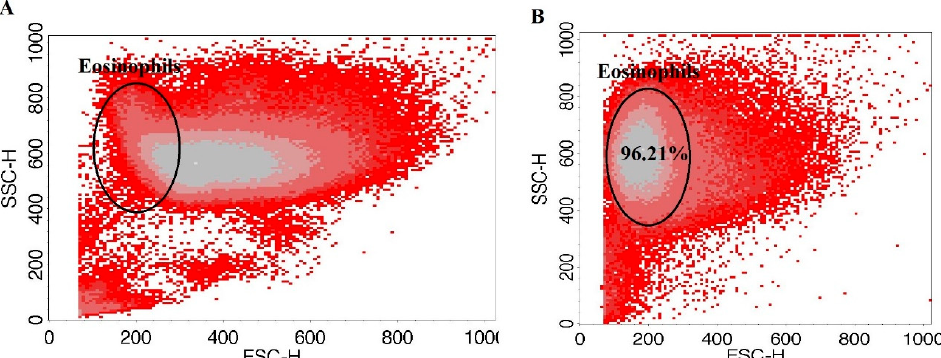
Figure 2. Eosinophil enrichment. ( A ) peripheral blood granulocytes after high-density centrifugation and erythrocyte lysis. ( B ) peripheral blood eosinophils after negative magnetic labeling and separation. Collected cell number—1 × 10 5 . Eosinophil quantity expressed from total collected cells counts rejecting debris.